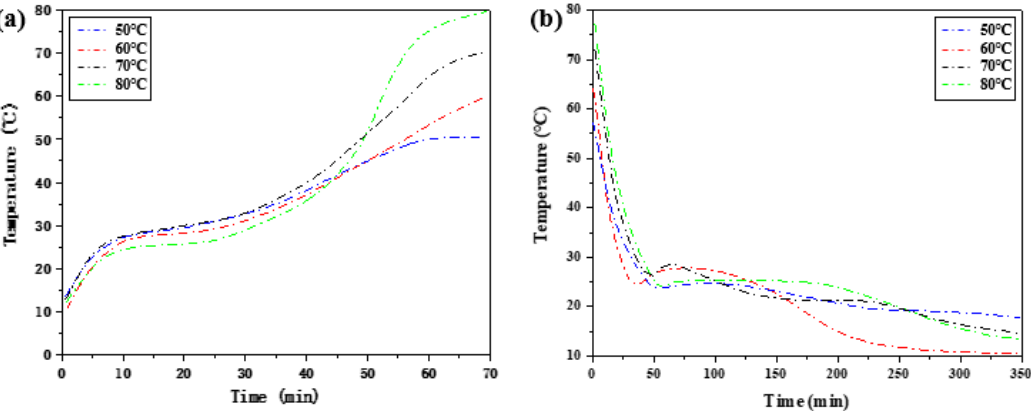
Figure 5. Heat storage and release step cooling curves of composite phase change materials at different heat storage temperatures. ( a ) Step heating curve of the heat storage process. ( b ) Step cooling curve of the exothermic process.